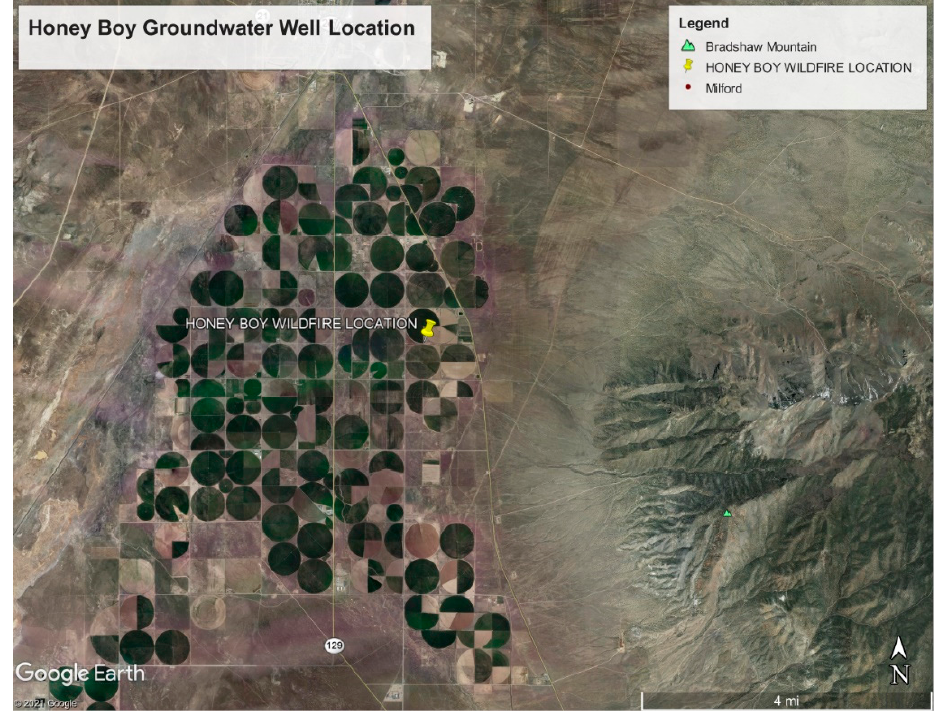
Figure 4. Location of the USGS groundwater well in Beaver County, Utah. Note its location within farmland area.